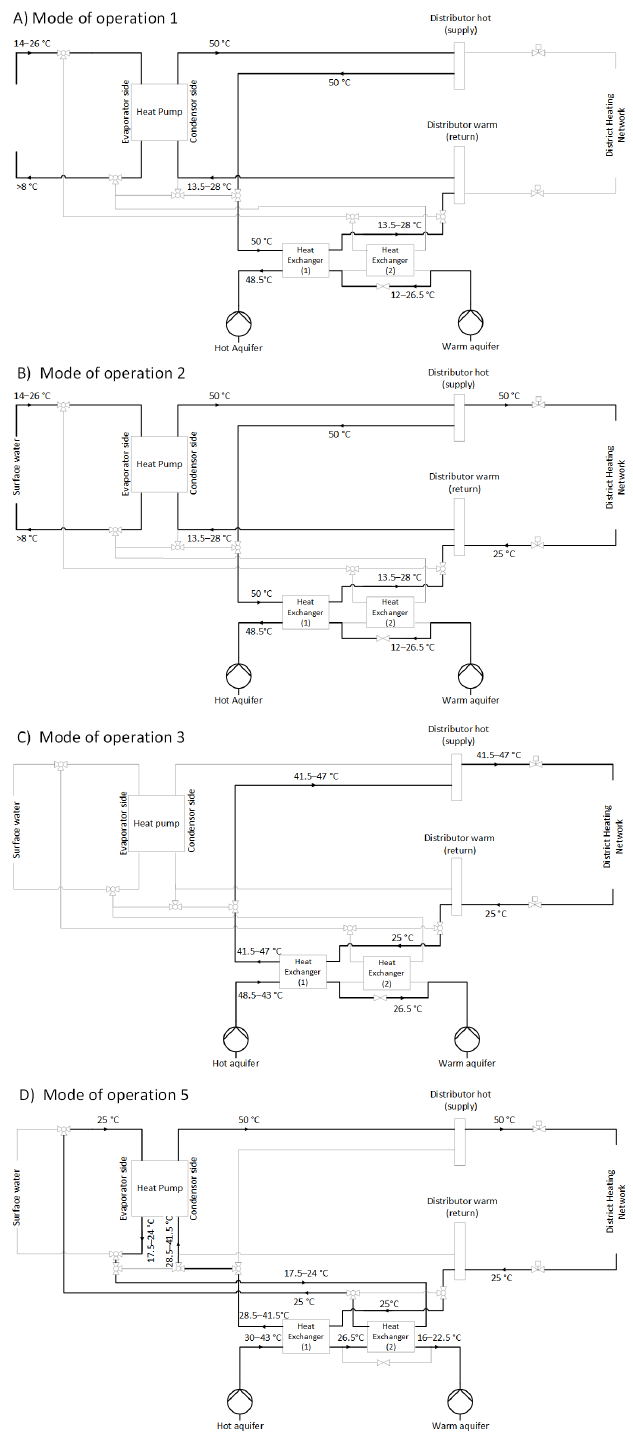
Figure 3. Overview of the hydraulic schemes for the different modes of operation. ( A ) Mode of operation 1: Heat production and storage in the HT-ATES. ( B ) Mode of operation 2: Simultaneous heat production and delivery. ( C ) Mode of operation 3: Heat delivery from the HT-ATES above the inlet temperature of the DHN. ( D ) Mode of operation 5: HT-ATES feeds heat pump mode for charging the HT-ATES with a heat pump condenser temperature of 50 ◦ C. In the mode of operation 4, the HT-ATES is shut-off, therefore no hydraulic scheme is shown. The shaded lines are inactive hydraulic connections, needed for other modes of operation. An indication of the temperature (range) of the different flows is